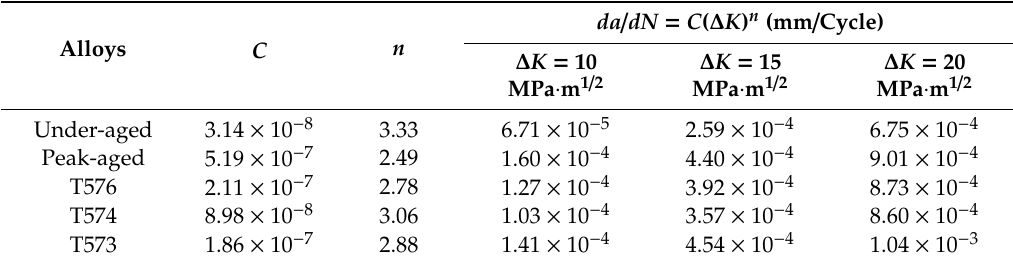
Figure 9. FCGR curves of ( a ) under-aged and peak aged and ( b ) T576, T574 and T573 alloys. Table 4. Fatigue crack growth data of the di ff erent aged